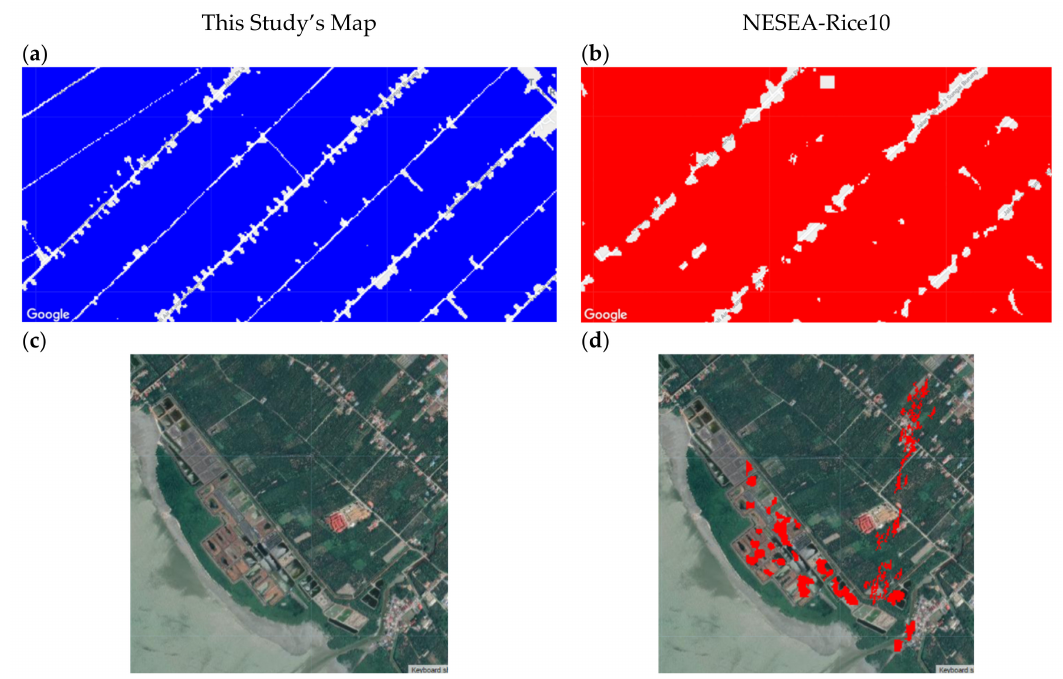
Figure 8. Visual comparison between this study’s rice (left sides) and the NESEA-Rice10 maps (right side); ( a , b ) show a comparison of the separability of rice and non-rice areas; ( c , d ) show a comparison of salt and pepper effects. The red colour is regions classified as rice field areas; comparison location is in Selangor state, Malaysia (3 ◦ 27 (cid:48) 5.83 (cid:48)(cid:48) N, 101 ◦ 7 (cid:48) 41.18 (cid:48)(cid:48)